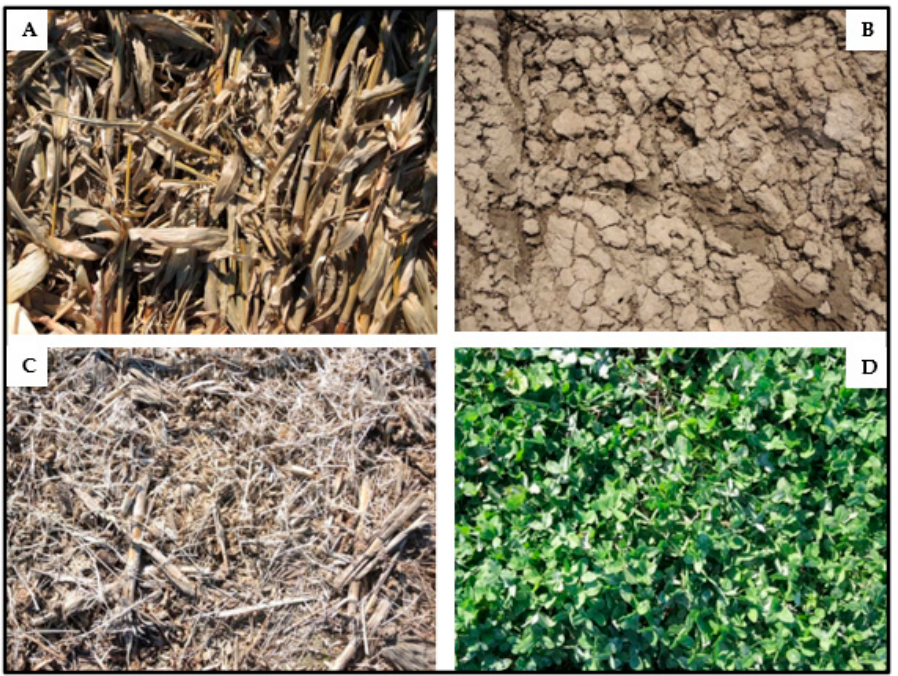
Figure 2. Examples of the pure endmembers used in this study: corn residue ( A ), bare soil ( B ), soybean residue ( C ), and green cover ( D ; alfalfa in this case).